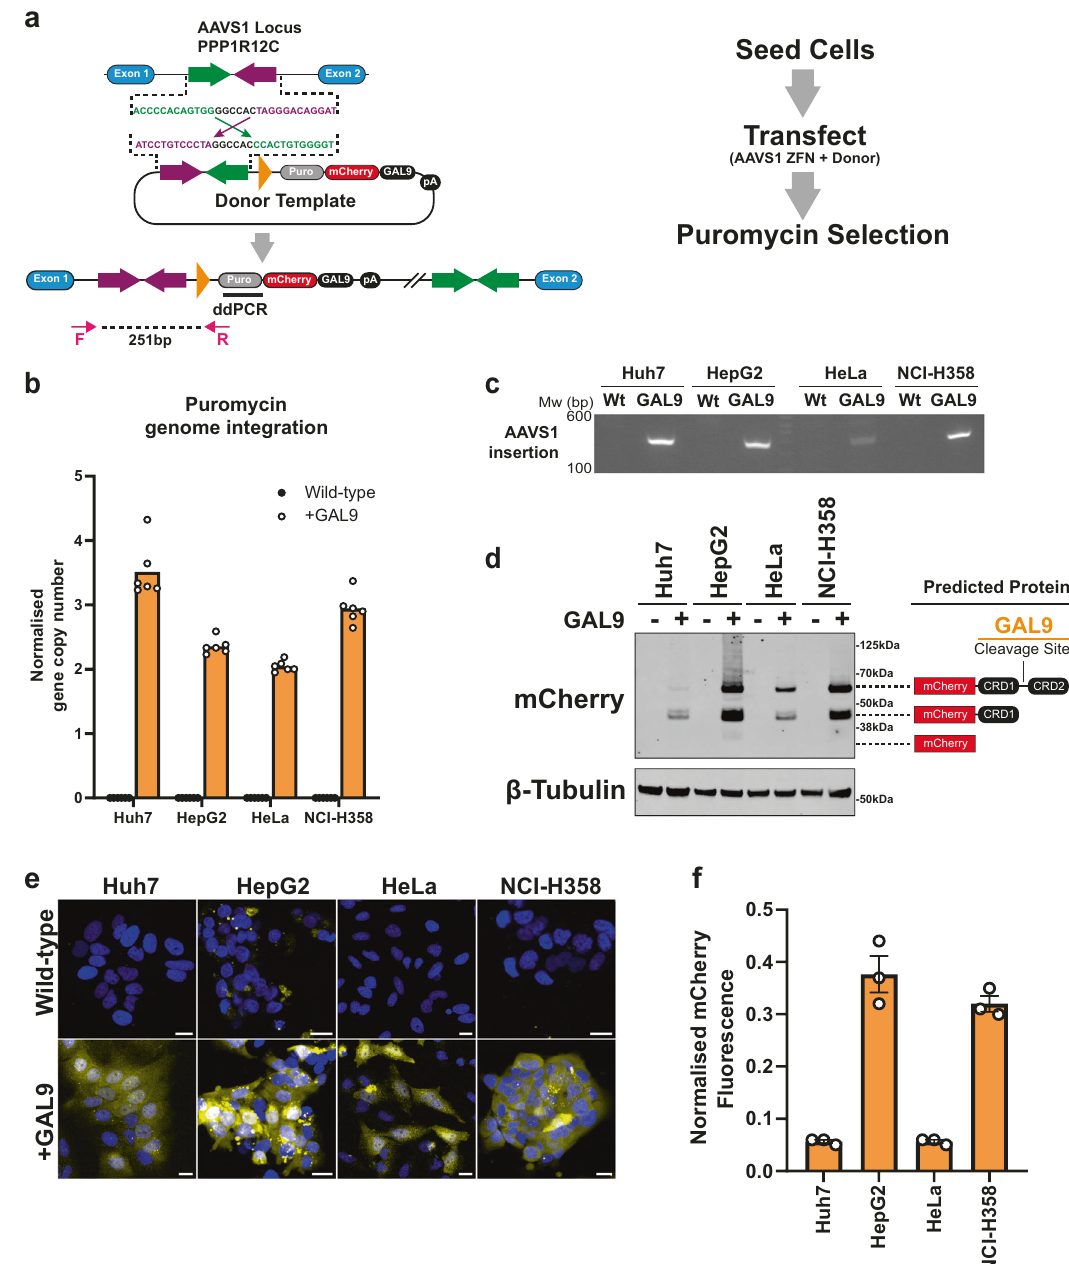
Fig. 1 Generation of mCherry-GAL9 knock-in cell lines. a Knock-In strategy for mCherry-GAL9. Reporter plasmid contains analogous zinc fi nger nuclease (ZFN) sites to AAVS1 locus. Co-transfection with an AAVS1 targeted ZFN induces a double-strand break and a non-homologous end-joining repair mechanism, resulting in mCherry-GAL9 insertion under an EF1 α promoter with a puromycin selection cassette. b Average copy number of puromycin genomic insertions per cell determined by droplet digital PCR from n = 6 replicates, normalised to the reference gene AP3B1, as an indirect measurement of mCherry-GAL9 insertions. c Representative agarose gel of the amplicon spanning the AASV1 locus and the donor mCherry-GAL9 donor vector, con fi rming the insertion of the construct at the expected genomic location. Molecular weight (base-pairs, bp) of standards is indicated next to the gel. d Western blot of stably integrated mCherry-GAL9 cell lines for indicated proteins and non-transfected cell controls, 40 µ g per lane. e Fluorescence images of Huh7, HepG2, HeLa and NCI-H358 cells± insertion of the mCherry-GAL9 reporter under normal growth conditions, scale bar = 20 µ m. Note: LUTs between cell lines vary (± mCherry-GAL9 reporter are matched), this is intended for clarity of GAL9 signal within cells. See ( f ) for true fl uorescent intensity. f Quantitation of cellular mCherry fl uorescence intensity from reporter lines. Values are normalised means from n = 3 independent experiments